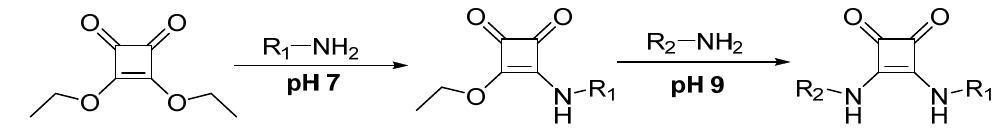
Figure 2. Asymmetric amidation of SADE with different amines. The reactions are driven by change in aromaticity of the different